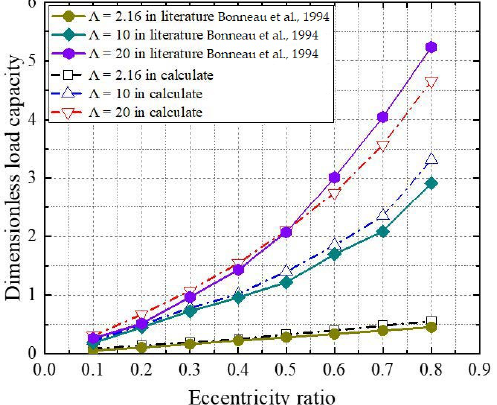
Figure 3. Model validation for dimensionless load capacity (length width ratio L / D = 1; groove angle α = 30 ◦ ; number of grooves N = 4; film clearance c 0 = groove depth h g = 10 µ m)